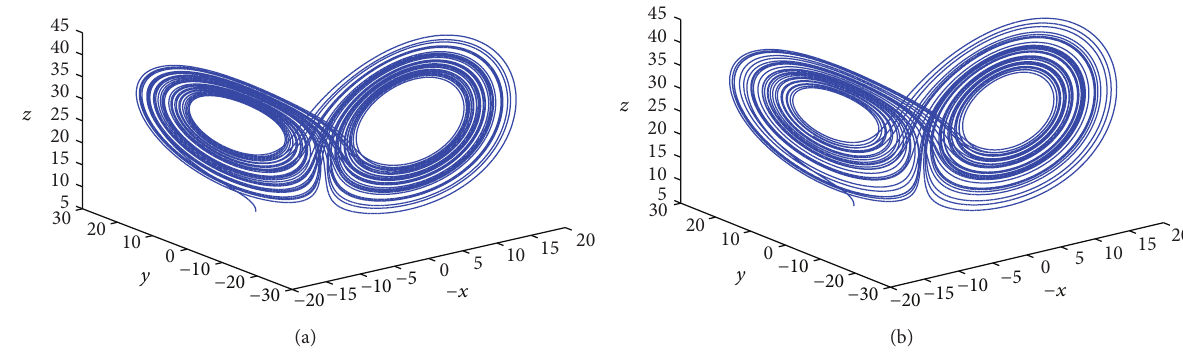
Figure 1: The phase portraits of 𝑥 - 𝑦 - 𝑧 for fractional Lorenz system 𝛼 = 𝛽 = 𝛾 = 0.98 (left) and 𝛼 = 𝛽 = 𝛾 = 0.99 (right) for the case 𝑟 = 1 .